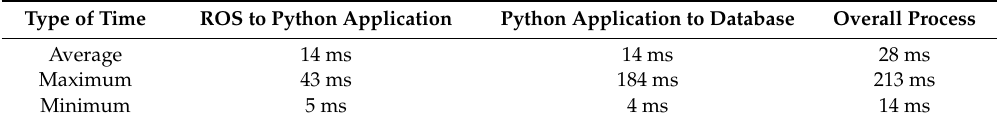
Table 4. Latency evaluation of the proposed C-ITS environment.